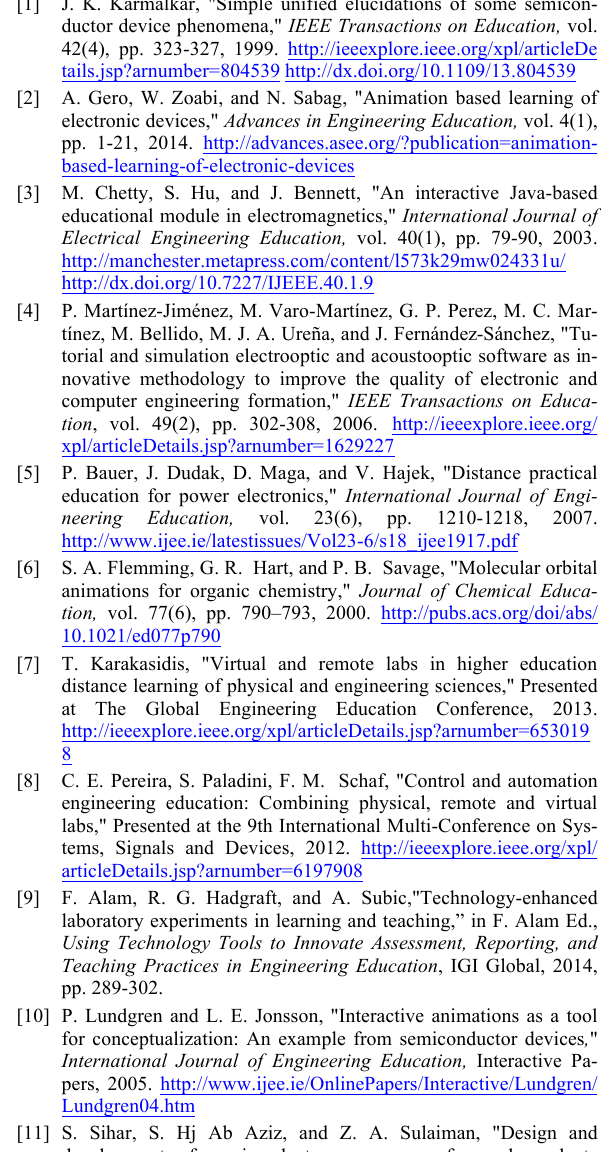
Figure 1. Sample question (Test 0)